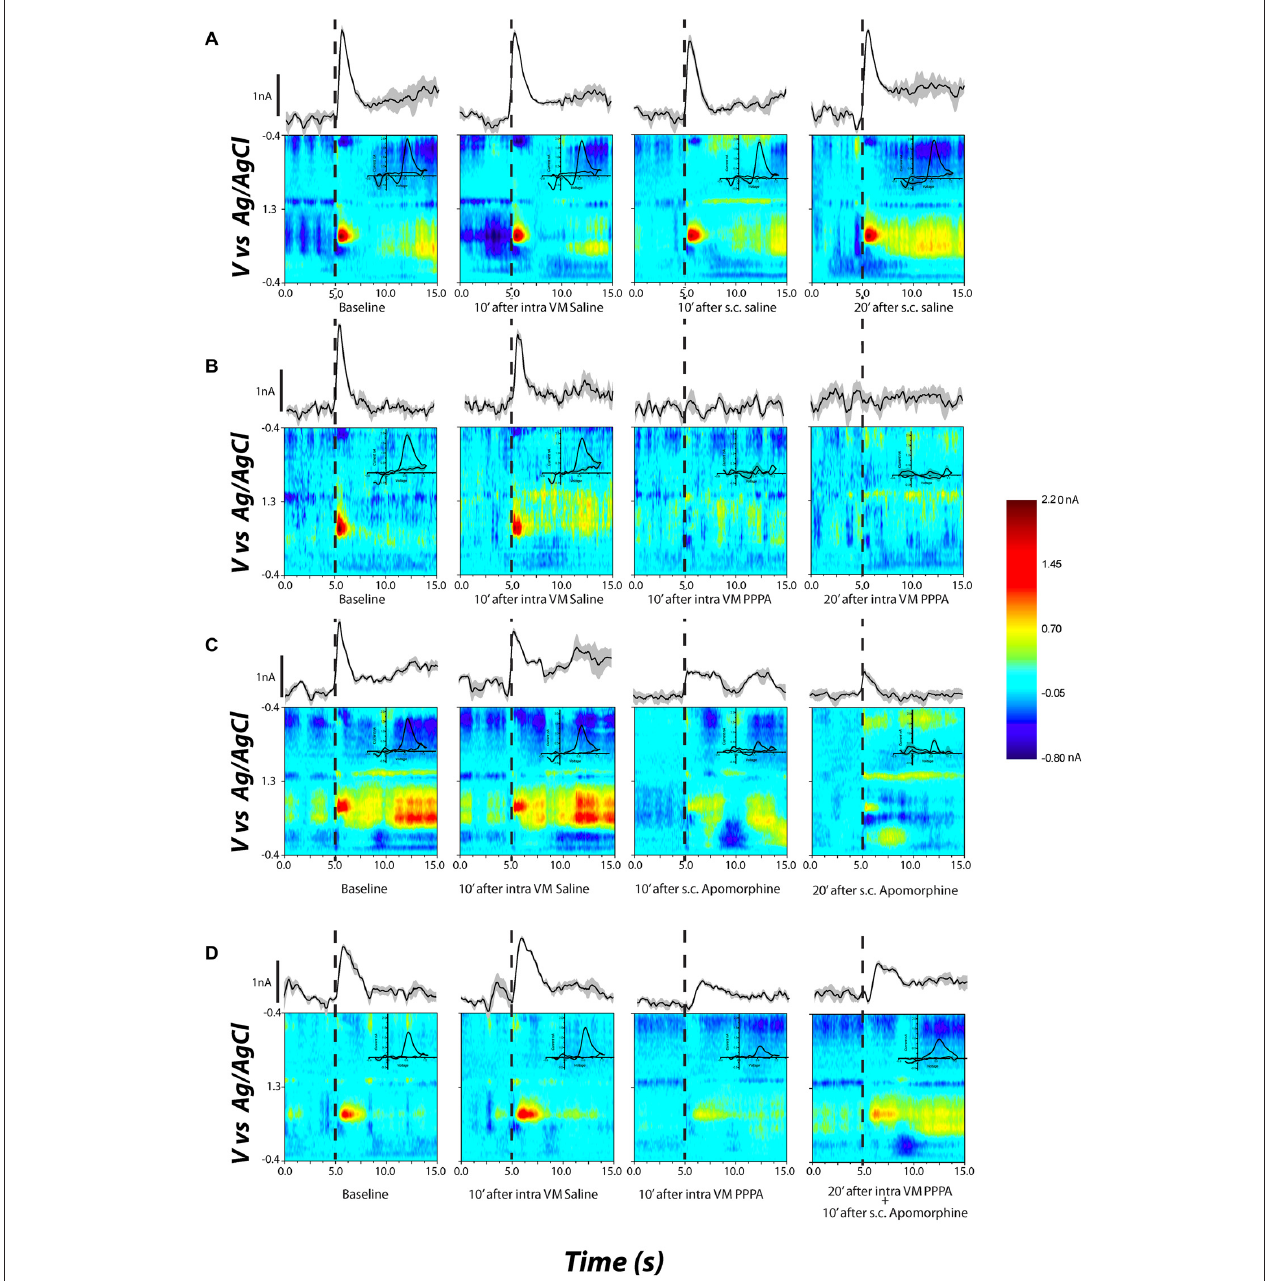
FIGURE 7 | Examples of DA release in the nucleus accumbens shell (NAcS) in response to electrical stimulation of the DR at M50 parameters. The false-color plots show redox currents as function of applied voltage and time. Current at the peak oxidation potential of DA is shown above the false-color plot as function of time. The insets show the cyclic voltammogram. Dashed lines denote the onset of the electrical stimulation train. (A) DA release for M50 stimulation at baseline, 10 min after intra-VM saline; 10 and 20 min after s.c. saline. The DA peak is quite stable over time and across conditions. (B) Intra-VM injection of PPPA alone produces a significant decrease in DA release. (C) A similar decrease in DA phasic release is observed after s.c. injection of apomorphine. (D) Administration of apomorphine 20 min after intra-VM injection of PPPA partially restored the magnitude of DA transient.